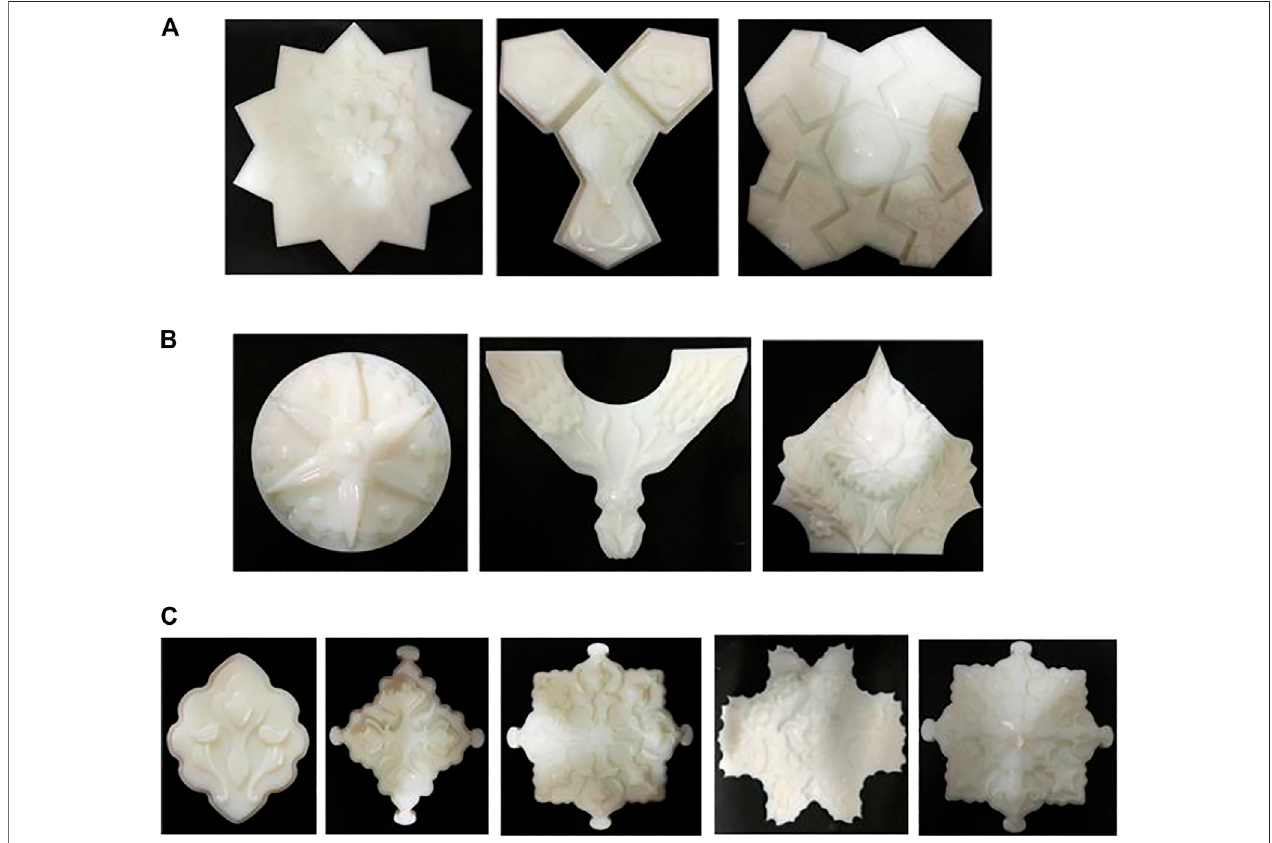
FIGURE 3 | Master molds of ceramic tiles in mosaics: (A) IGP/IBM tiles (pattern 005); (B) Iznik tiles (pattern 007); (C) Safavid tiles (pattern 008).